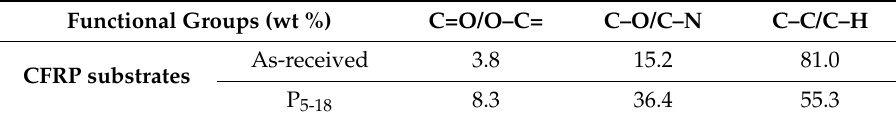
Figure 10. High resolution XPS scans of C 1 s on the as-received and plasma-treated (P 5-18 ) CFRP substrate surfaces. Table 7. XPS peak fitting method describing carbon functional group distribution.